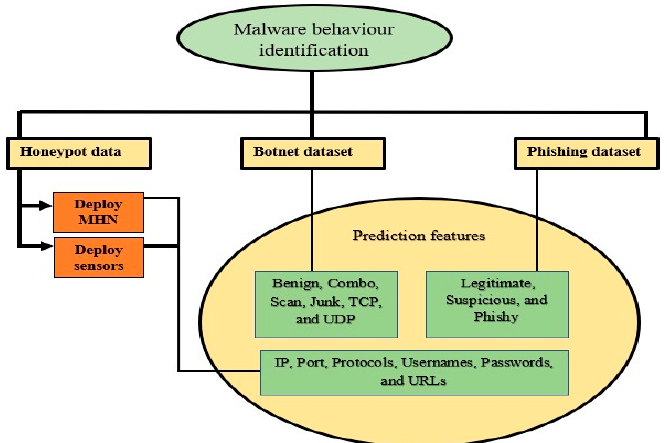
Figure 2. Design phases of the research in three datasets.